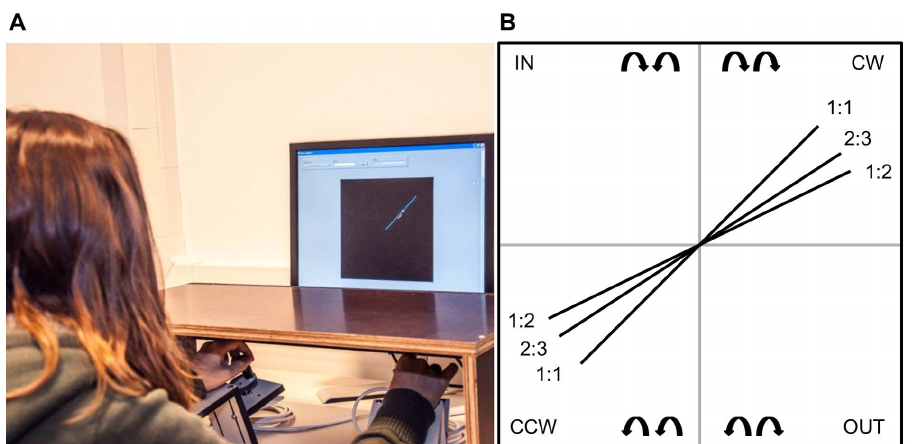
Figure 1. Bimanual tracking task (BTT). (A)Taskset-up . Subjects were seated in front of a computer screen on which the task was displayed. The response apparatus consisted of two dials which were fixated on a ramp. Direct vision of the forearms was prevented by a horizontal table-top bench. (B)Frequencyratiosandcoordinationdirections . Schematic drawing of the target lines shown on the screen, from which subjects can deduct the three frequency ratios (1:1, 2:3 and 1:2) and coordination directions [clockwise (CW) and counterclockwise (CCW)]. The coordination directions inwards (IN) and outwards (OUT) are shown here, but are not a part of the training protocol.